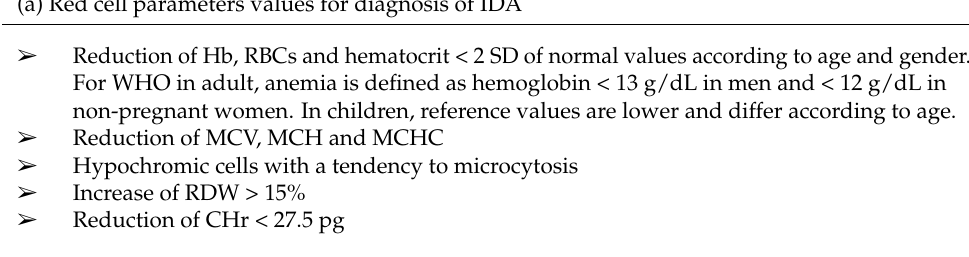
Table 2. Parameters for IDA